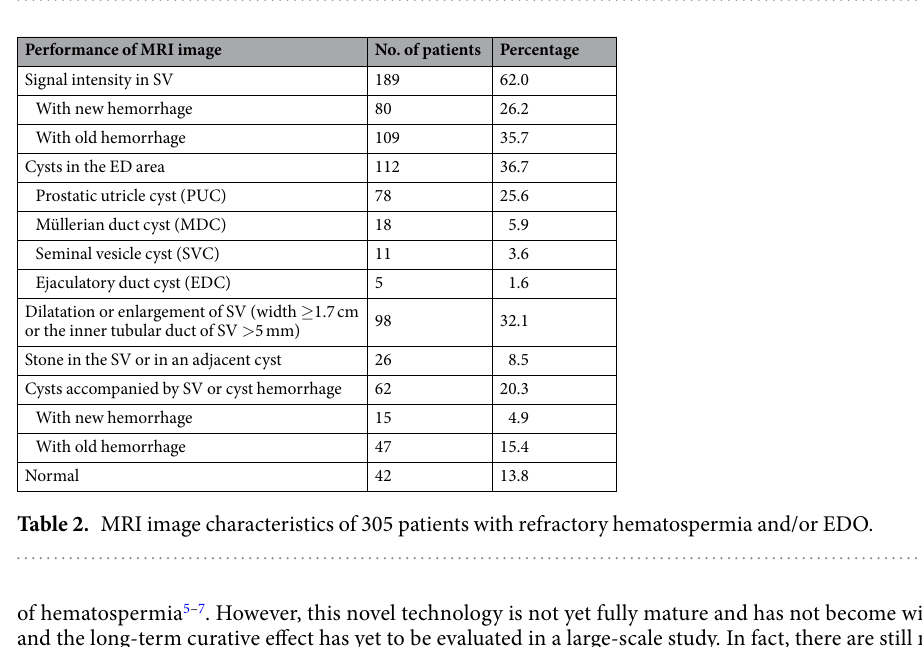
Table 1. Symptoms of 305 patients with refractory hematospermia and/or EDO.